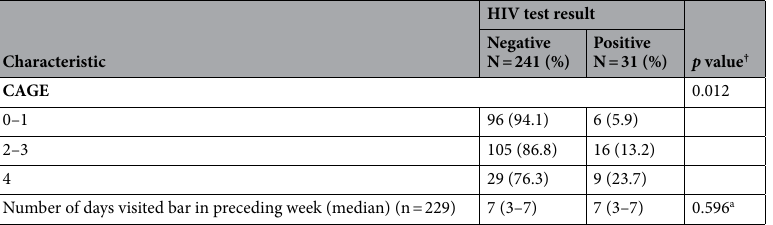
Table 2. Characteristics of HIV positive individuals found at bars in slums of Kampala. † p value is generated from Pearson’s chi-square test, 1 p value is from Fisher’s exact test, a p-value is from Ranksum test.